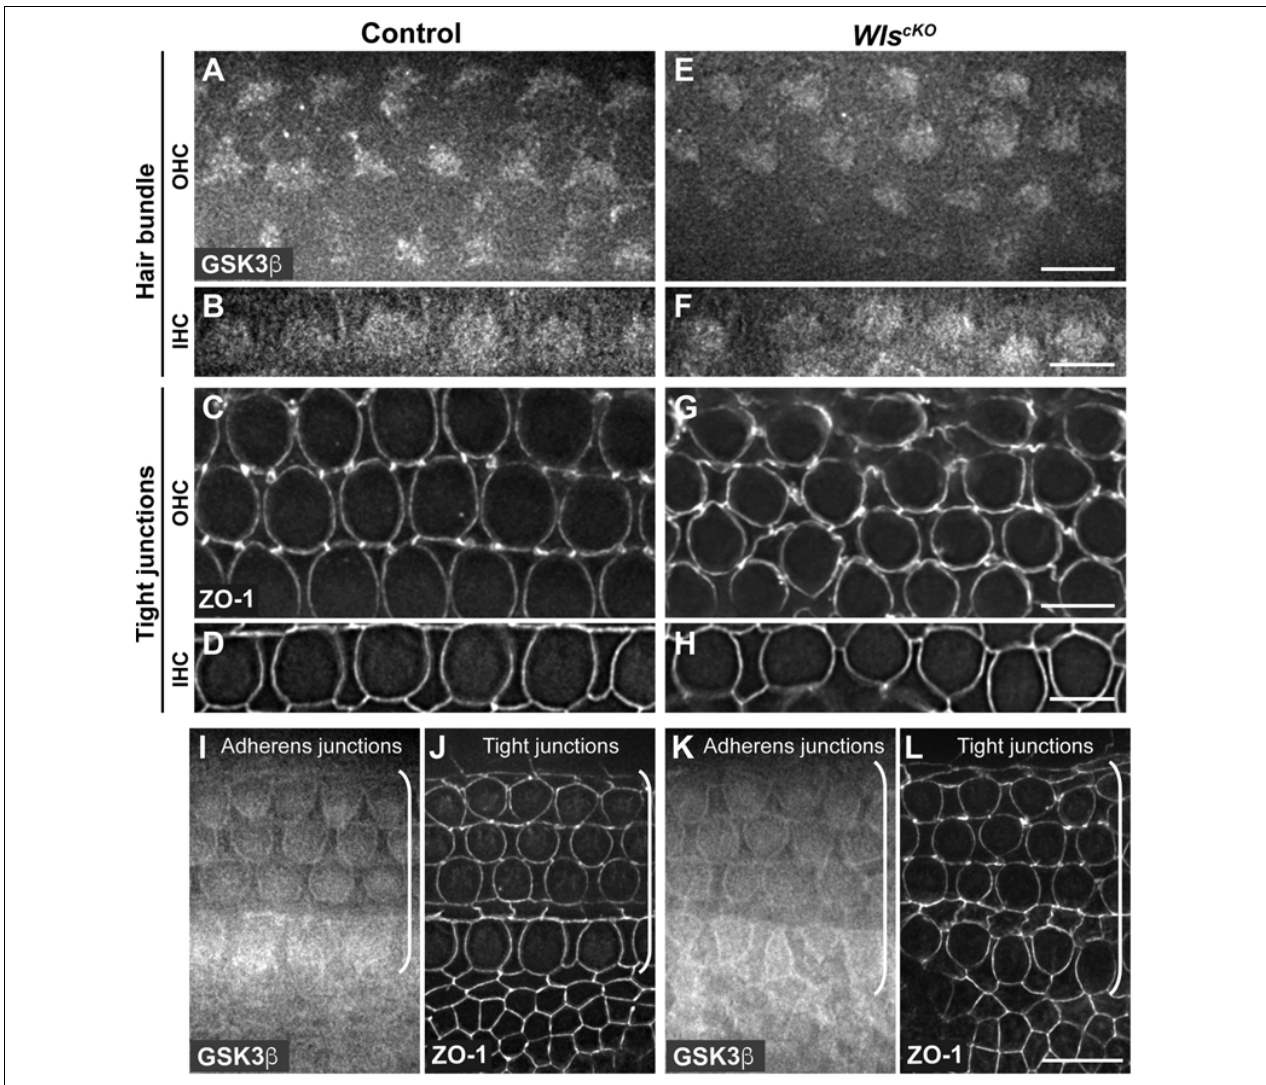
FIGURE 2 | Similar Gsk3 β localizations in control and Wls cKO cochleae. (A–H) Gsk3 β staining at the level of hair bundle and ZO-1 staining at the level of tight junctions in control (A–D) and Wls cKO (E–H) OC at E18.5. (I–L) Gsk3 β staining at the level of adherens junctions and ZO-1 staining at the level of tight junctions in control (I,J) and Wls cKO (K,L) OC and surrounding regions. Brackets indicate the OC. Lateral is up. Scale bars: (A–L) , 6 µ m; (M–P) , 10 µ